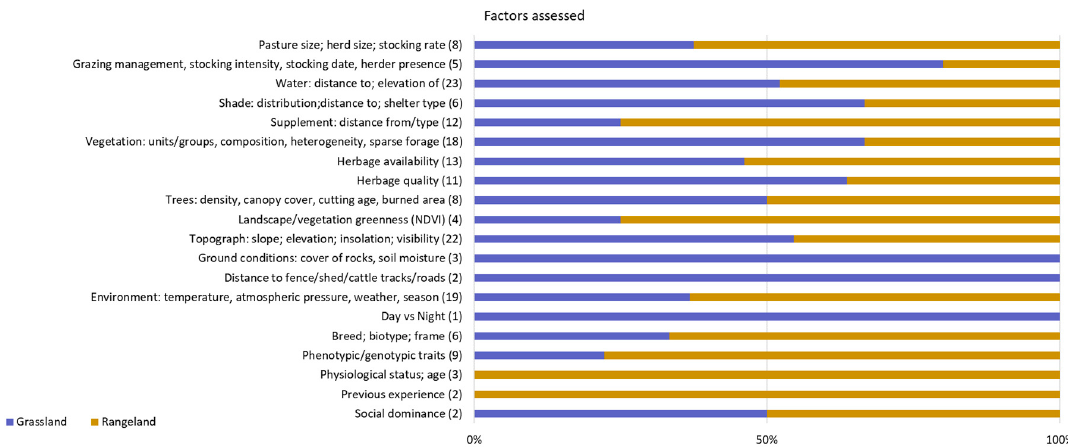
Figure 4. Categories of factors assessed in studies published between 2000 and 2020 on the use of GPS tracking on cattle to determine the factors affecting their site use preference on grazing systems (numbers between brackets refer to the total number of studies carried out only in grasslands and rangelands that included the assessment of each factor class).